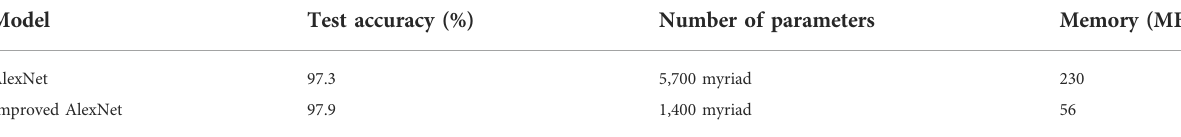
TABLE 3 Comparison of two